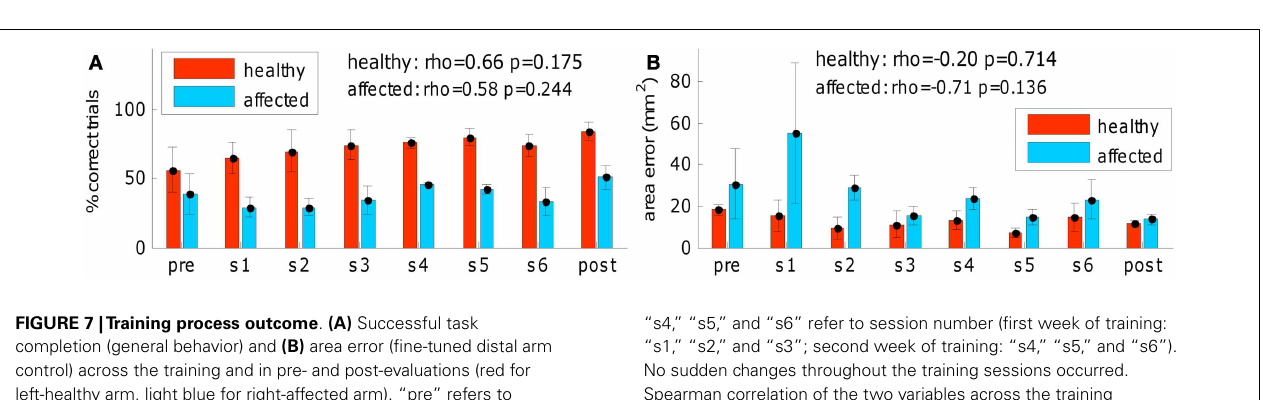
“s4,” “s5,” and “s6” refer to session number (first week of training: “s1,” “s2,” and “s3”; second week of training: “s4,” “s5,” and “s6”). No sudden changes throughout the training sessions occurred. Spearman correlation of the two variables across the training sequence is reported for both